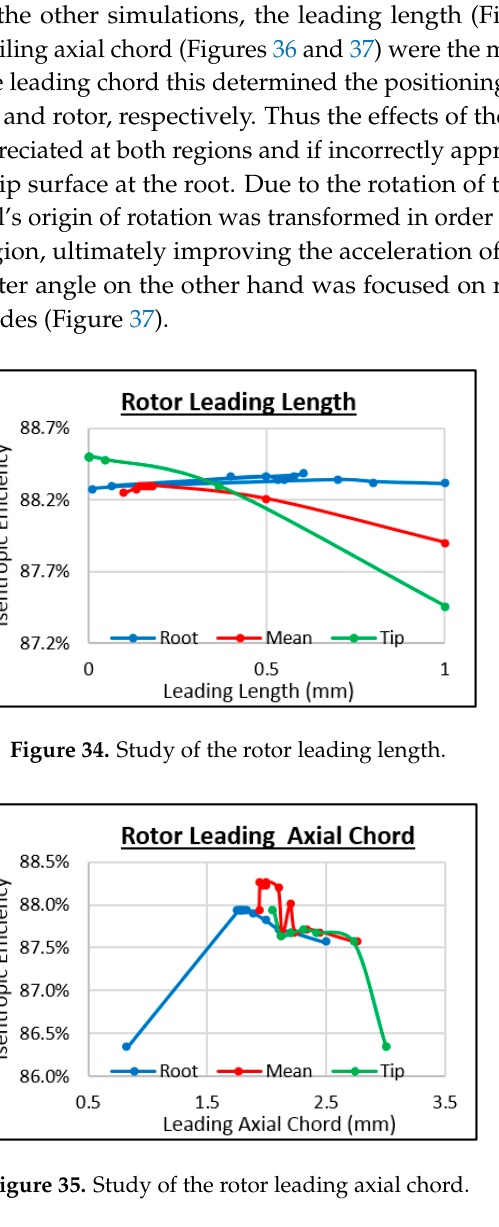
Figure 33. Study of the rotor leading radius.